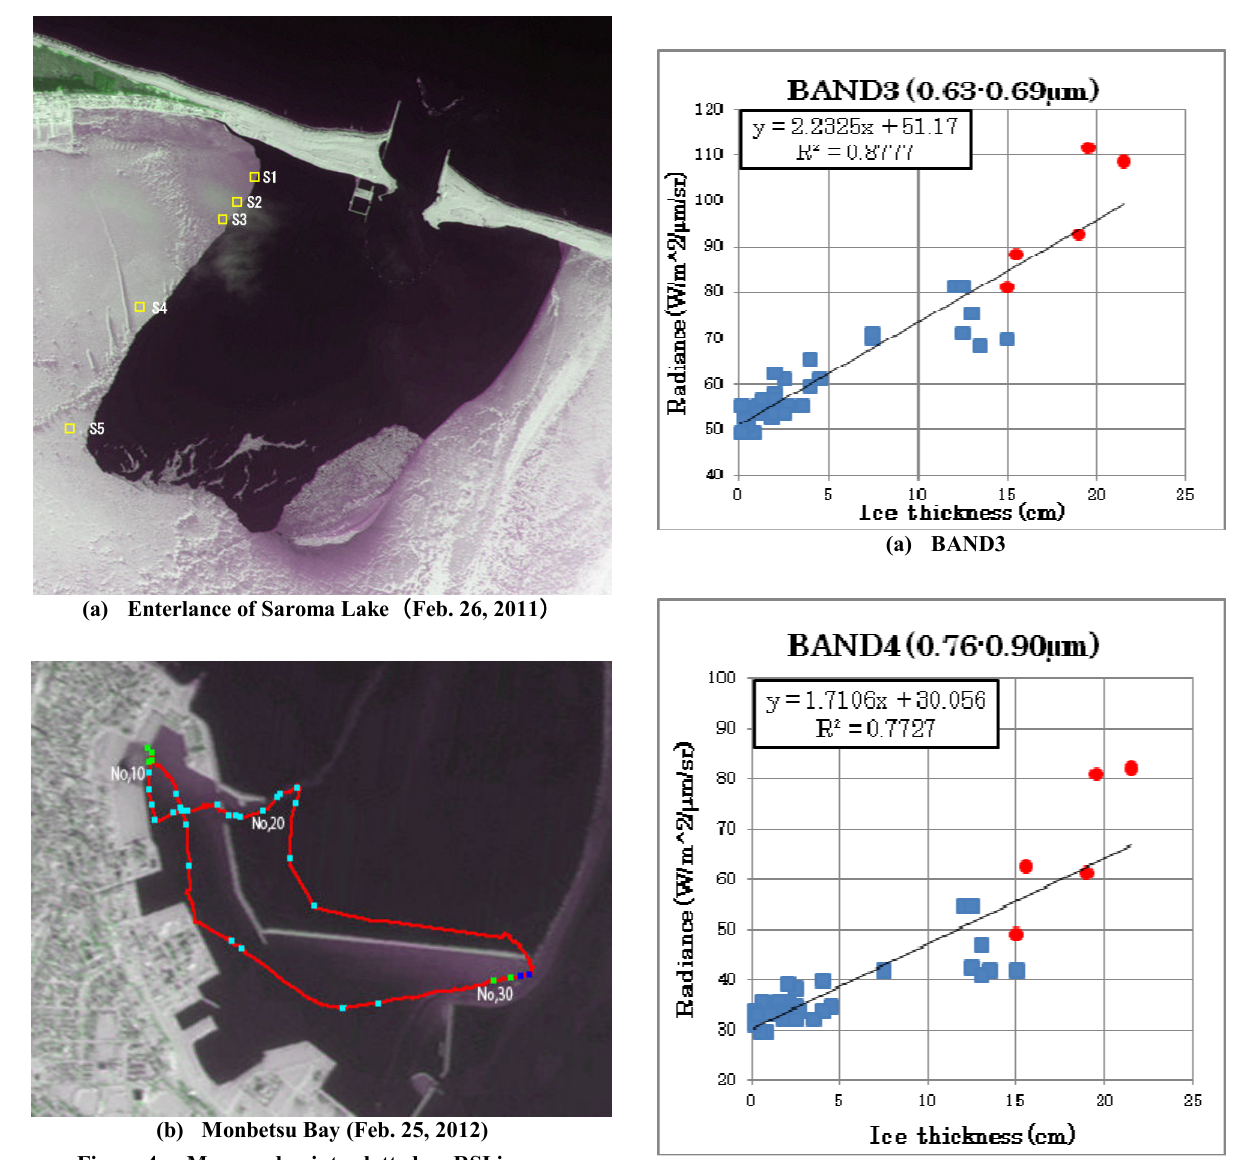
Figure 4. Measured points plotted on RSI images